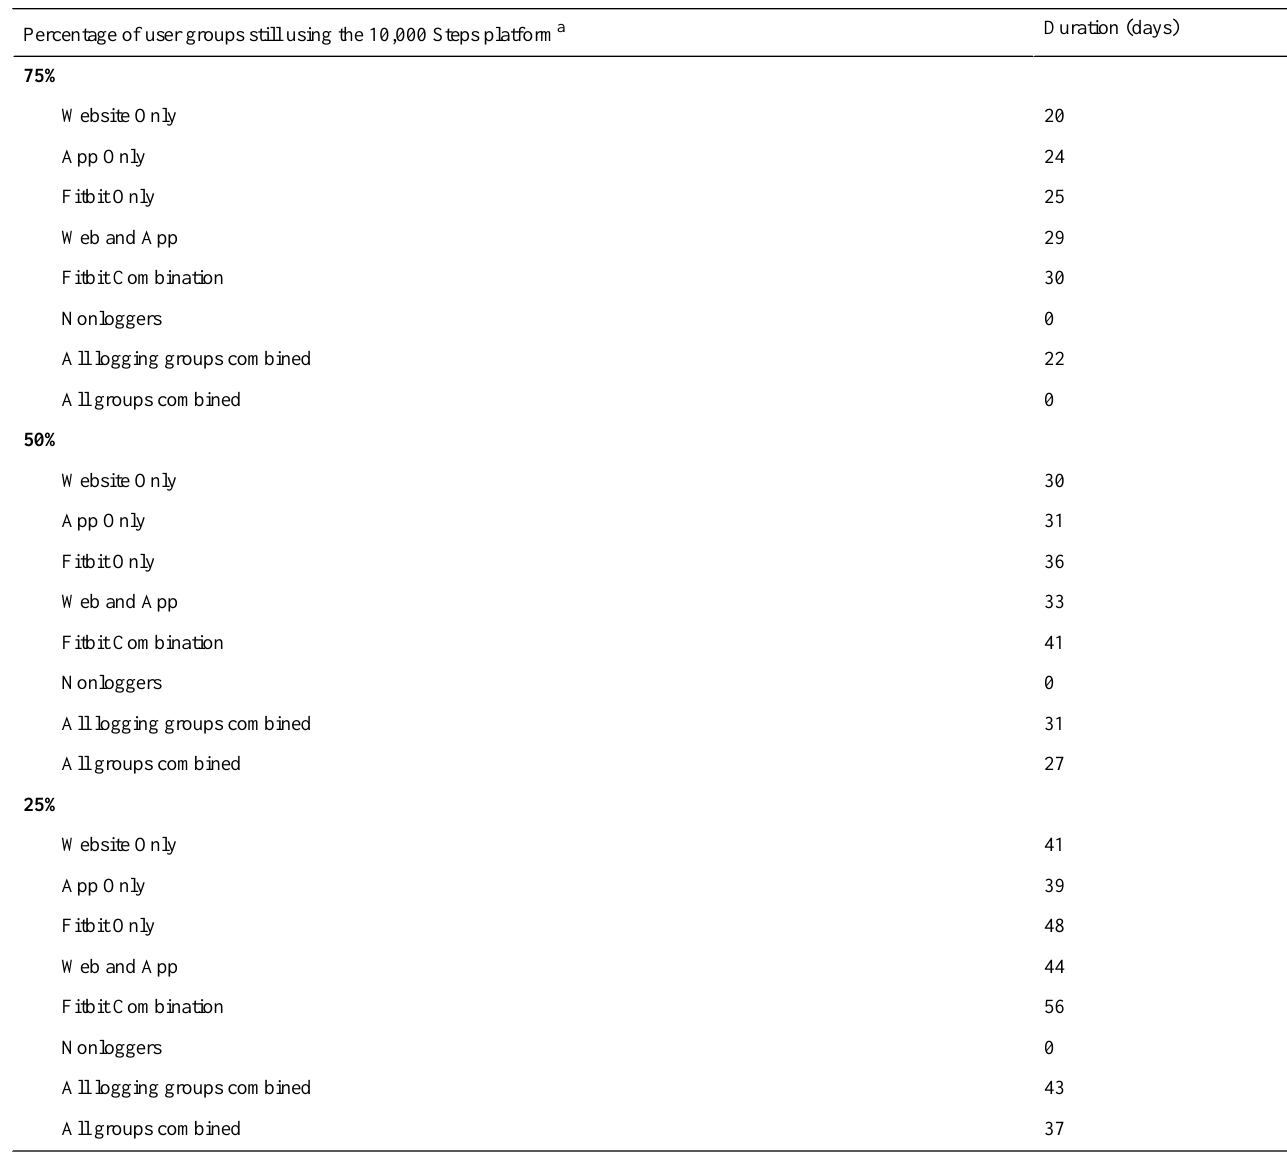
Table 5. Survival time by group of users of the 10,000 Steps program (N=30,040).